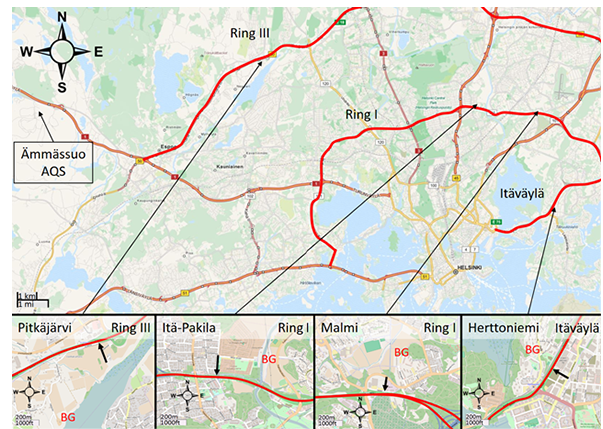
Figure 1. Four gradient measurement locations in the Helsinki re- gion. In the subplots, the black arrows show the driving direction on the gradient roads and BG depicts the local background mea- surement sites. Also shown is a meteorological measurement site at Ammässuo.